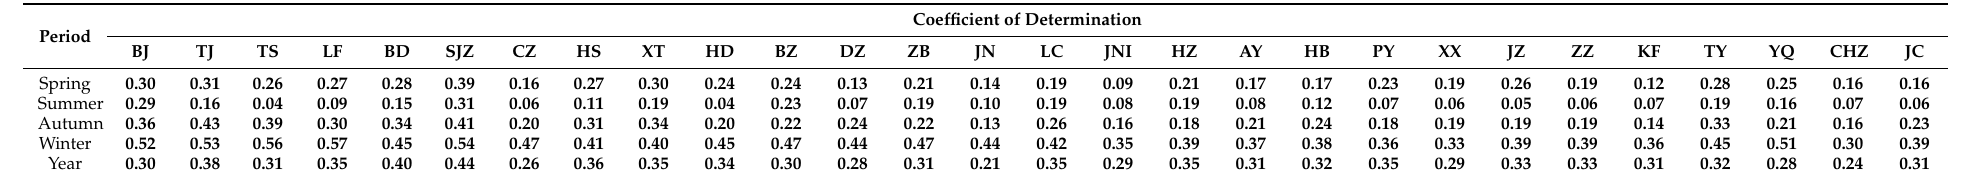
Table 2. Coefficients of determination (R 2 ) for multiple linear regression of PM 2.5 concentration with meteorological variables based on daily data from 2014 to 2019 at the annual and seasonal scales: BJ, Beijing; TJ, Tianjin; SJZ, Shijiazhuang; TS, Tangshan; LF, Langfang; BD, Baoding; CZ, Cangzhou; HS, Hengshui; XT, Xingtai; HD, Handan; BZ, Binzhou; DZ, Dezhou; ZB, Zibo; JN, Jinan; LC, Liaocheng; JNG, Jining; HZ, Heze; AY, Anyang; HB, Hebi; PY, Puyang; XX, Xinxiang; JZ, Jiaozou; ZZ, Zhengzhou; KF, Kaifeng; TY, Taiyuan; YQ, Yangquan; CHZ, Changzhi; JC,